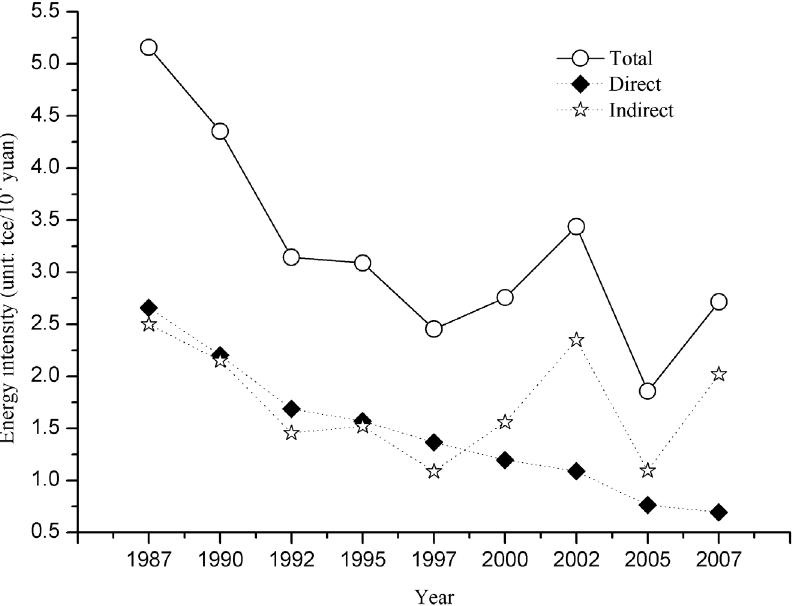
Figure 2. The changes of energy consumption intensity of Beijing city from 1987 to 2007.